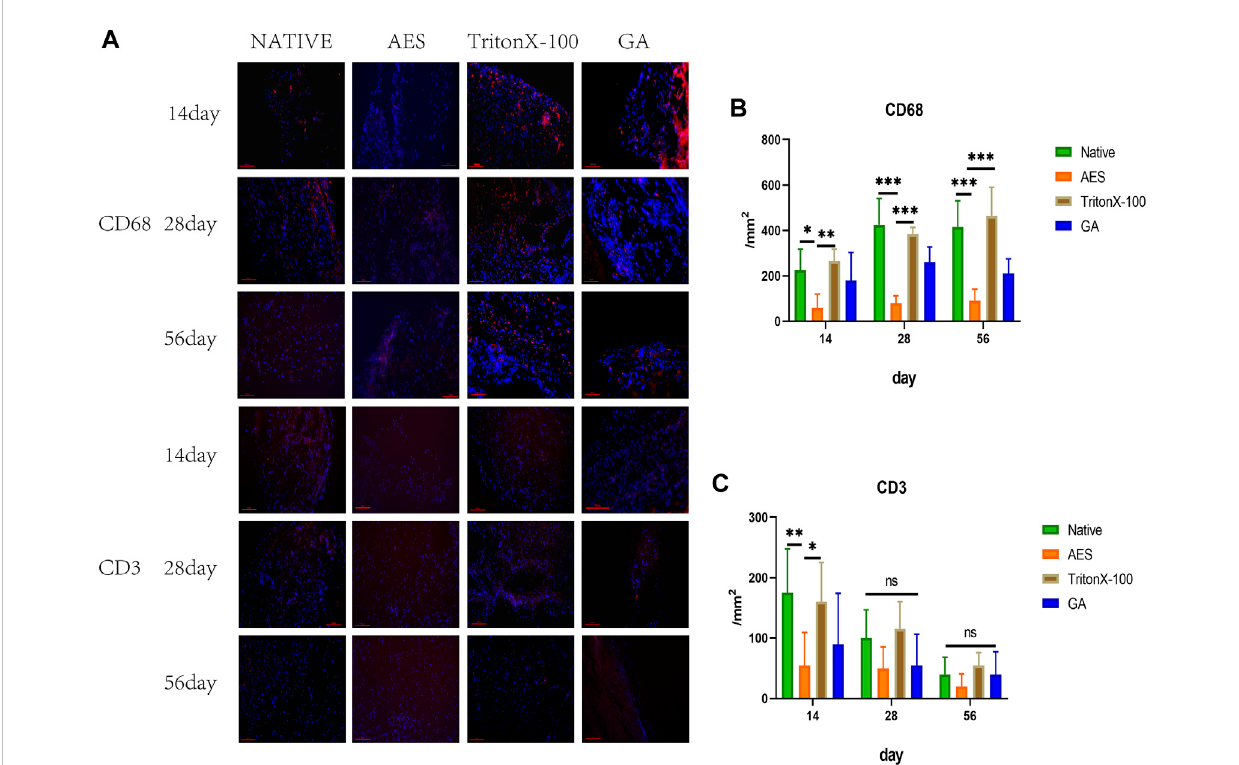
FIGURE 8 (A) Immuno fl uorescence staining of 14 days, 28 days, 56 days after subcutaneous implantation, immuno fl uorescence were used to observe the different types of in fl ammatory cells marker, CD68 + Macrophages (red) scale bars are 100 um, CD3 + T cell (red) scale bars are 100 um; The number of CD68 + macrophages (B) and CD3 + T cells (C) after subcutaneous implantation(n = 5; * p < 0.05; ** p < 0.01; *** p < 0.001; ns represents no signi fi cant difference).